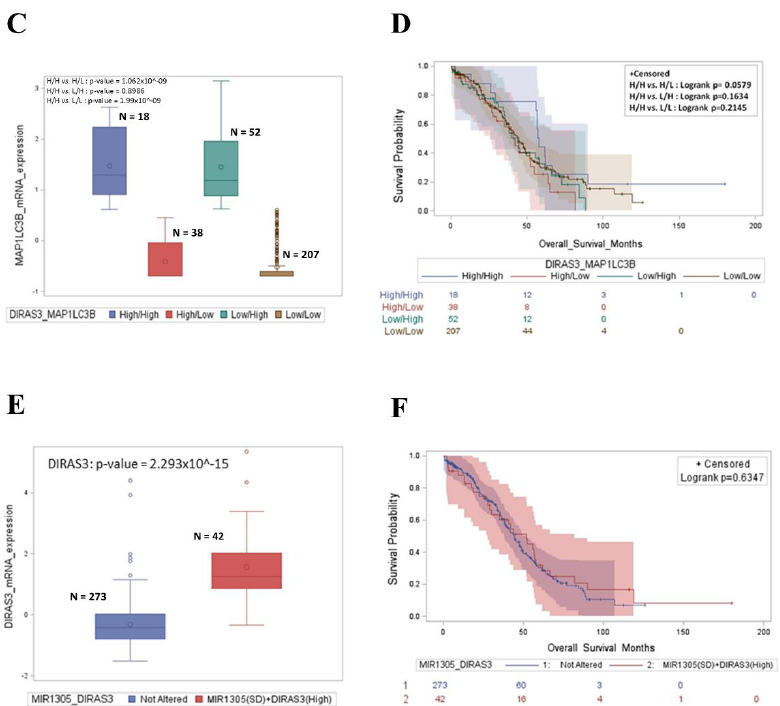
Figure 10. Patients with a high expression of DIRAS3 / MAP1LC3B together with CDKN1A upregu- lation have better overall survival and this correlates with MIR1305 downregulation. ( A ) Scatter plot representing the correlation between DIRAS3 and CDKN1A mRNA expression. ( B ) Scatter plot rep- resenting the correlation between MAP1LC3B and CDKN1A mRNA expression. The Spearman’s and Pearson’s correlation coefficients and p -value were used to determine statistical significance. The p - value ≤ 0.05 was considered significant. ( C ) Box-plot showing the distribution of DIRAS3 mRNA expression according to MAP1LC3B mRNA levels (High/High, High/Low, Low/High, Low/Low). ( D ) Kaplan–meier plot representing the overall survival status of patients stratified in the four-group analysis (High DIRAS3 /High MAP1LC3B (H/H), High DIRAS3 /Low MAP1LC3B (H/L), Low DIRAS3 /High MAP1LC3B (L/H), Low DIRAS3 /Low MAP1LC3B (L/L)). The p -value was considered significant. ( E ) Box-plot showing the distribution of DIRAS3 mRNA expression according to MIR1305 CNV status (shallow deletion (SD) vs . not altered (includes rest of patients without the shallow deletion of MIR1305 )). ( F ) Kaplan–meier plot representing the overall survival status of patients stratified in not altered vs . SD MIR1305 + High DIRAS3